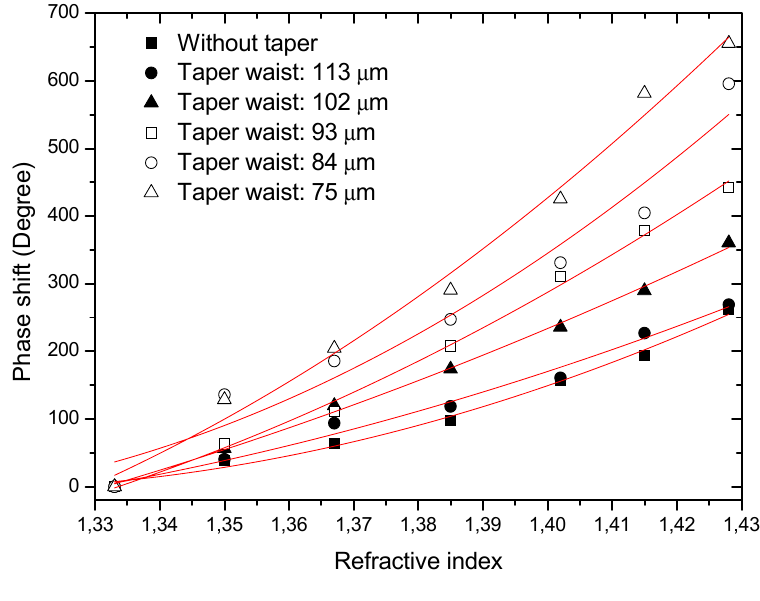
Figure 4. Sensing system phase changes due to refractive index variations for a tapered LPG-based Mach-Zehnder interferometer with different taper waist